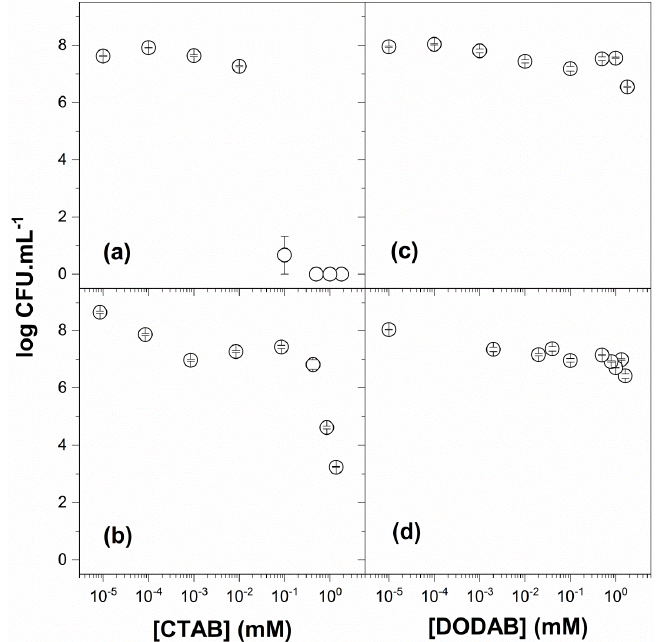
Figure 6. Viability of Staphylococcus aureus in the presence of CTAB (a), PMMA/CTAB (b), DODAB (c), and PMMA/DODAB dispersions (d). The NP dispersions of PMMA/CTAB and PMMA/DODAB were used after dialysis. The counting of colony-forming unities (CFU) was expressed on a logarithmic